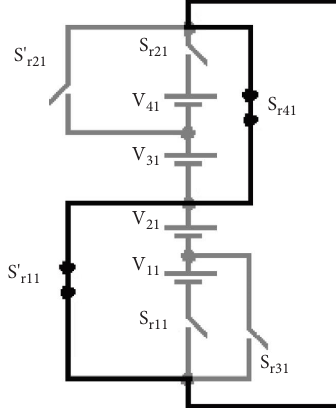
Figure 6: Operating mode for zero